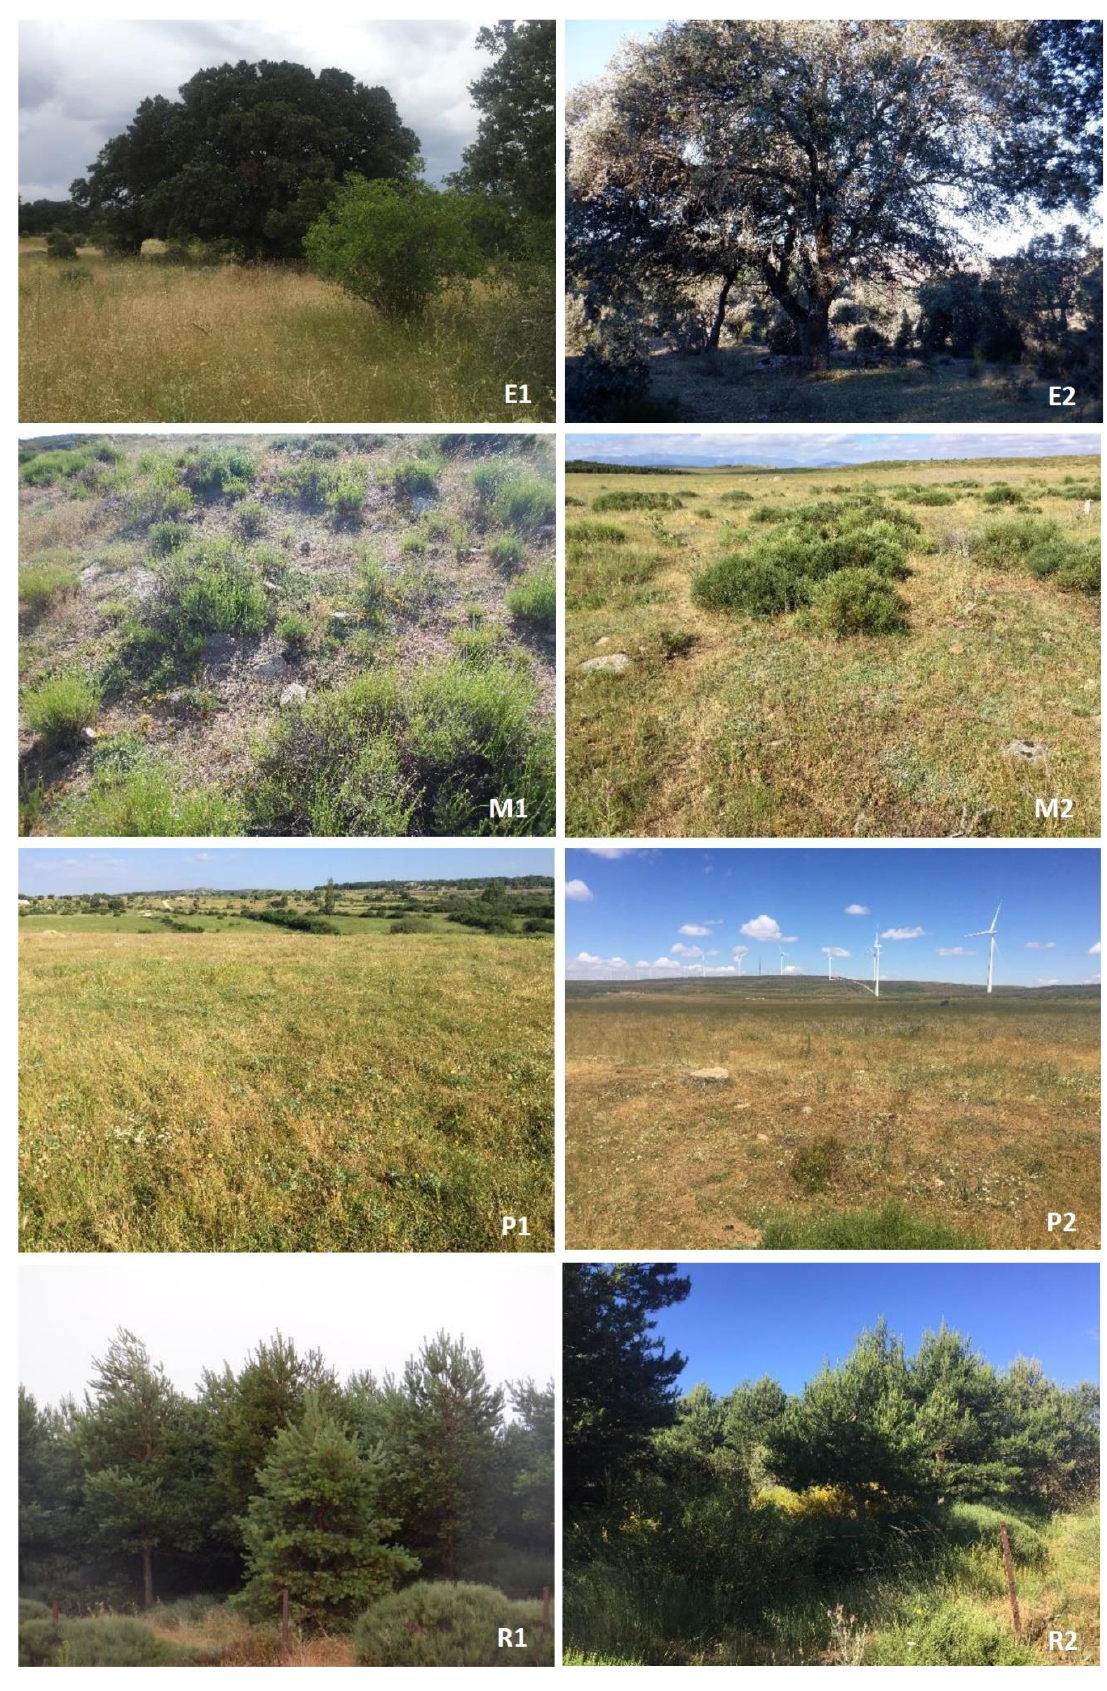
Figure 2. Sampling plots with the different types of vegetation: pine forest (recent afforestation) ( R1 , R2 ), holm oak forest ( E1 , E2 ), shrubs ( M1 , M2 ), and grasslands ( P1 , P2 ) .